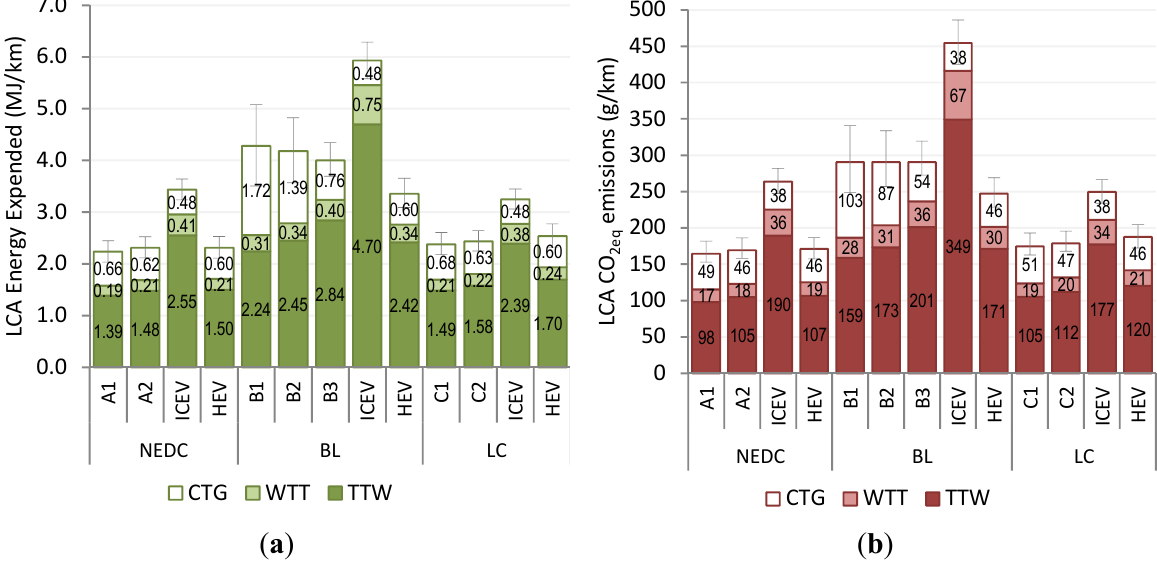
Figure 8. Life cycle energy use ( a ) and CO 2eq emissions ( b ), of the reference and optimal vehicles in NEDC, BL and LC driving cycles, for a lifetime distance of 200,000